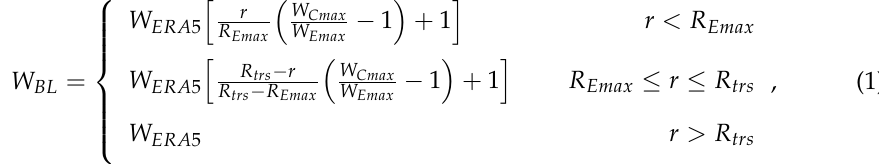
Figure 11. Spatial distribution of the simulated significant wave height at ( a ) 00:00 on 14 September 2016, ( b ) 00:00 on 17 September 2016, and ( c ) 00:00 on 27 September 2016, using the D04 computation domain and ERA5 wind